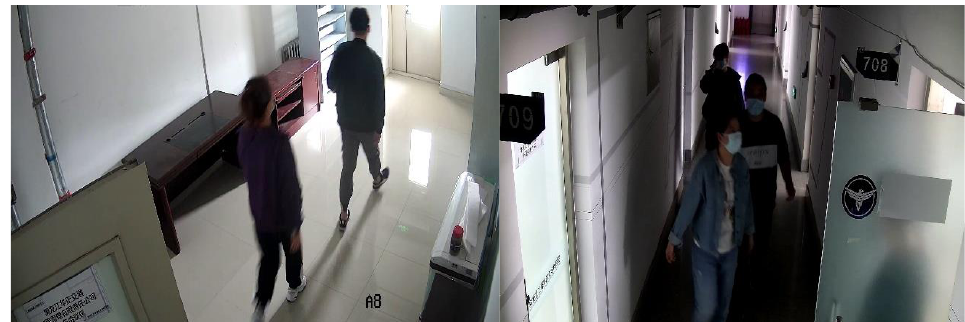
Figure 16. Examples of sonar image datasets.